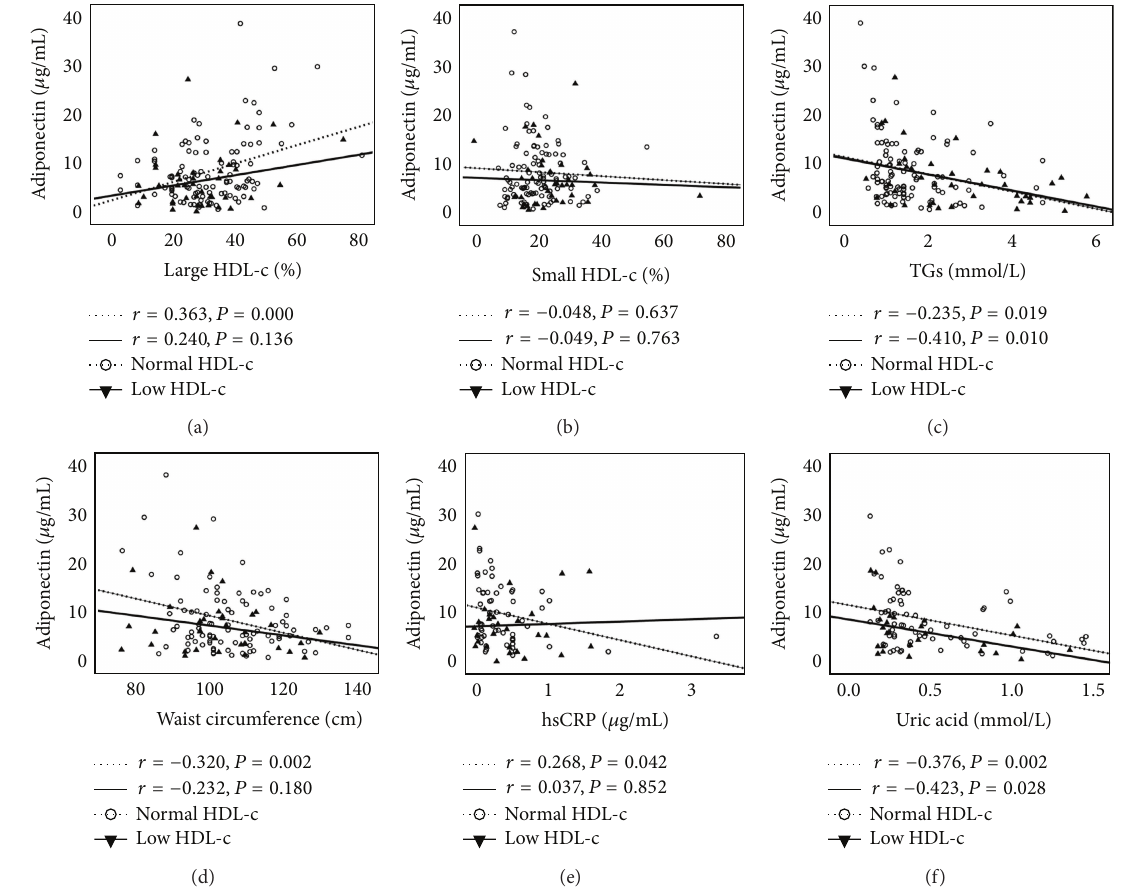
Figure 5: Main correlations in normal and low-HDL-c patients. Correlation between adiponectin and large HDL-c (a), small HDL-c (b), TGs (c), waist circumference (d), hsCRP (e), and uric acid (f).